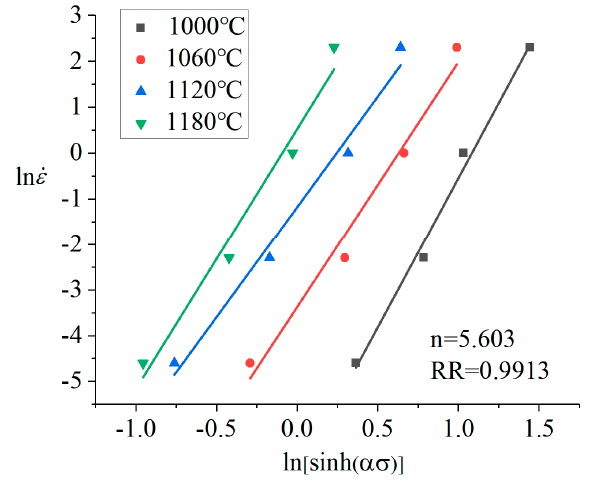
. ε and ln[sinh( ασ